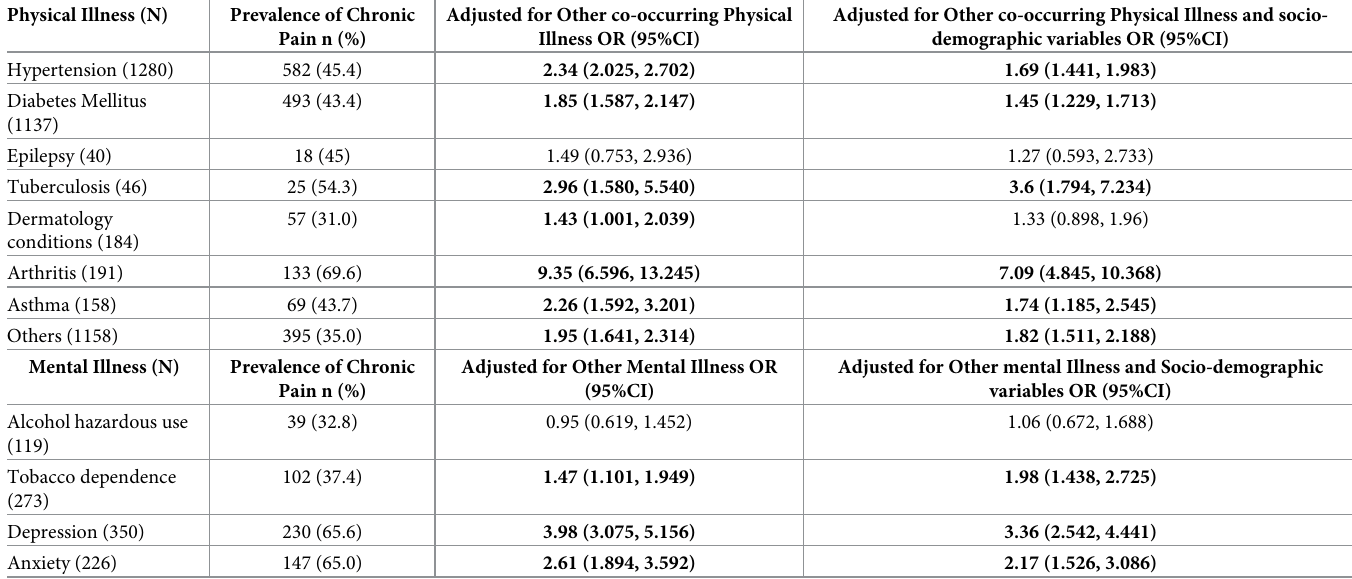
Table 3. Prevalence of chronic pain in physical and mental disorders with risk ratios adjusted for other physical/mental illness and socio-demographic